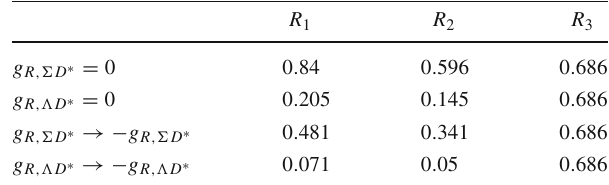
Table 4 Values of R 1 , R 2 , R 3 obtained by both changing the sign of the g R , BD ∗ couplings or setting them to zero